Question: Which kind of chart has been used to present this data?
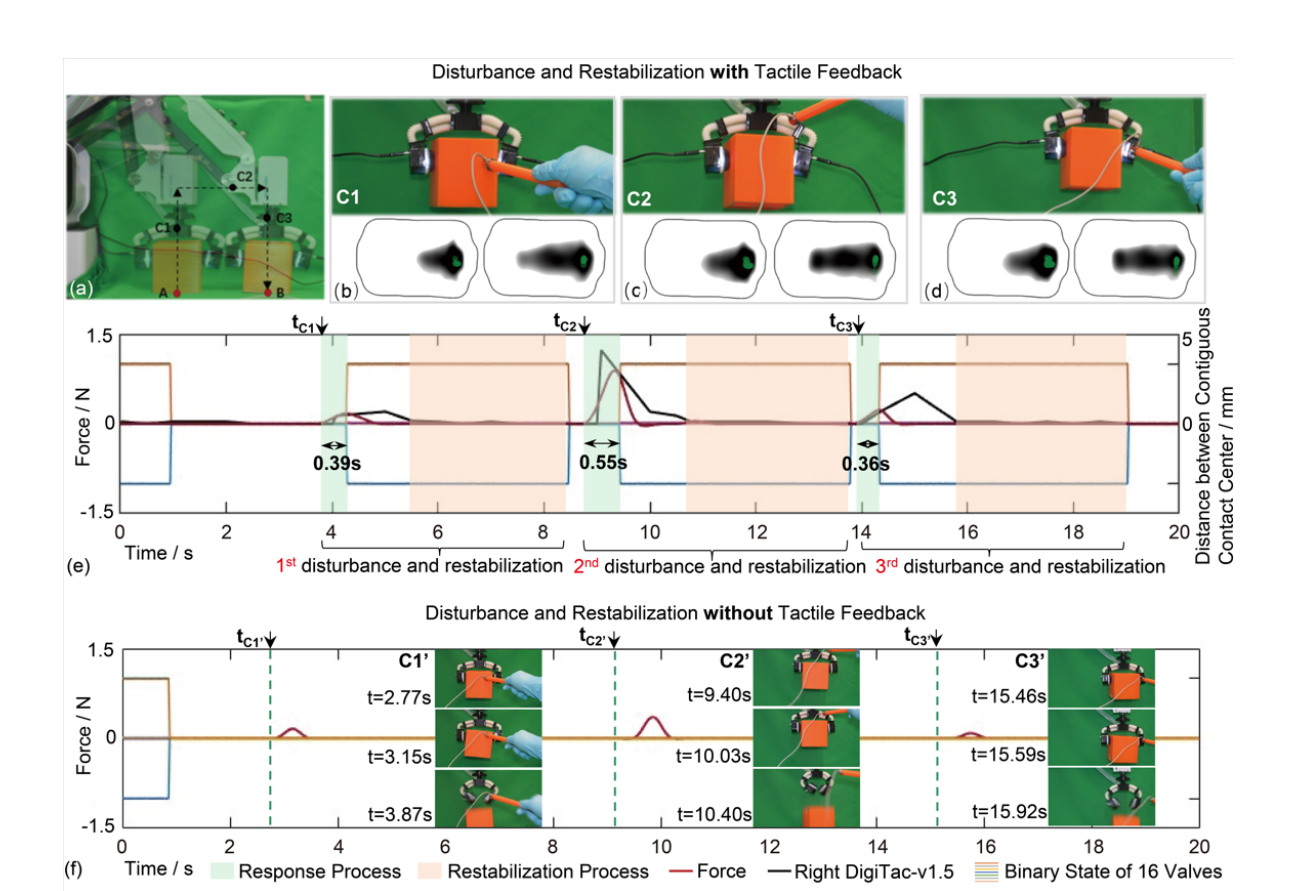
Answer: line